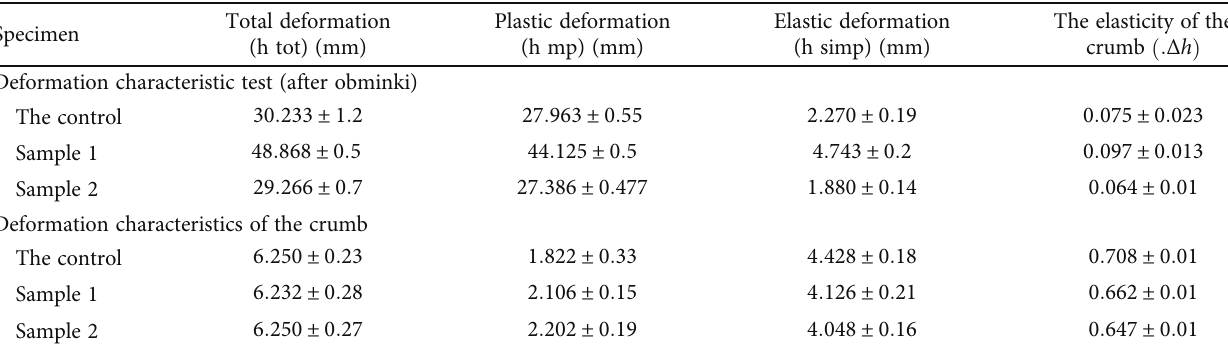
Table 4: The rheological characteristics of dough and crumb of bread prototypes.